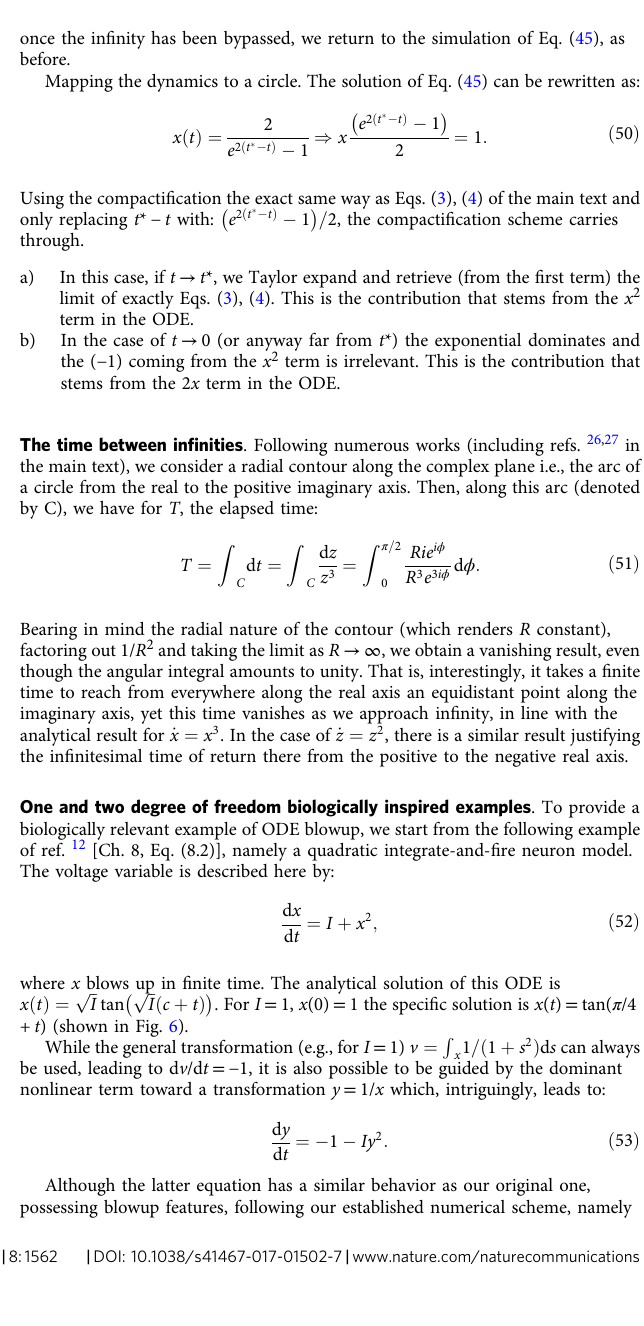
Fig. 7 Passing in fi nity numerically for the 1D quadratic integrate-and- fi re neuronal model. Repeatedly: a integrate Eq. (52) until x suf fi ciently approaches blowup, b integrate the transformed Eq. (53) to pass y smoothly through 0. For our simulations, we have set I = 1, initial condition x (0) = 1; time integration was performed using the ode45 matlab solver 55 with Relative tolerance = 1. E − 08 and absolute tolerance = 1. E −